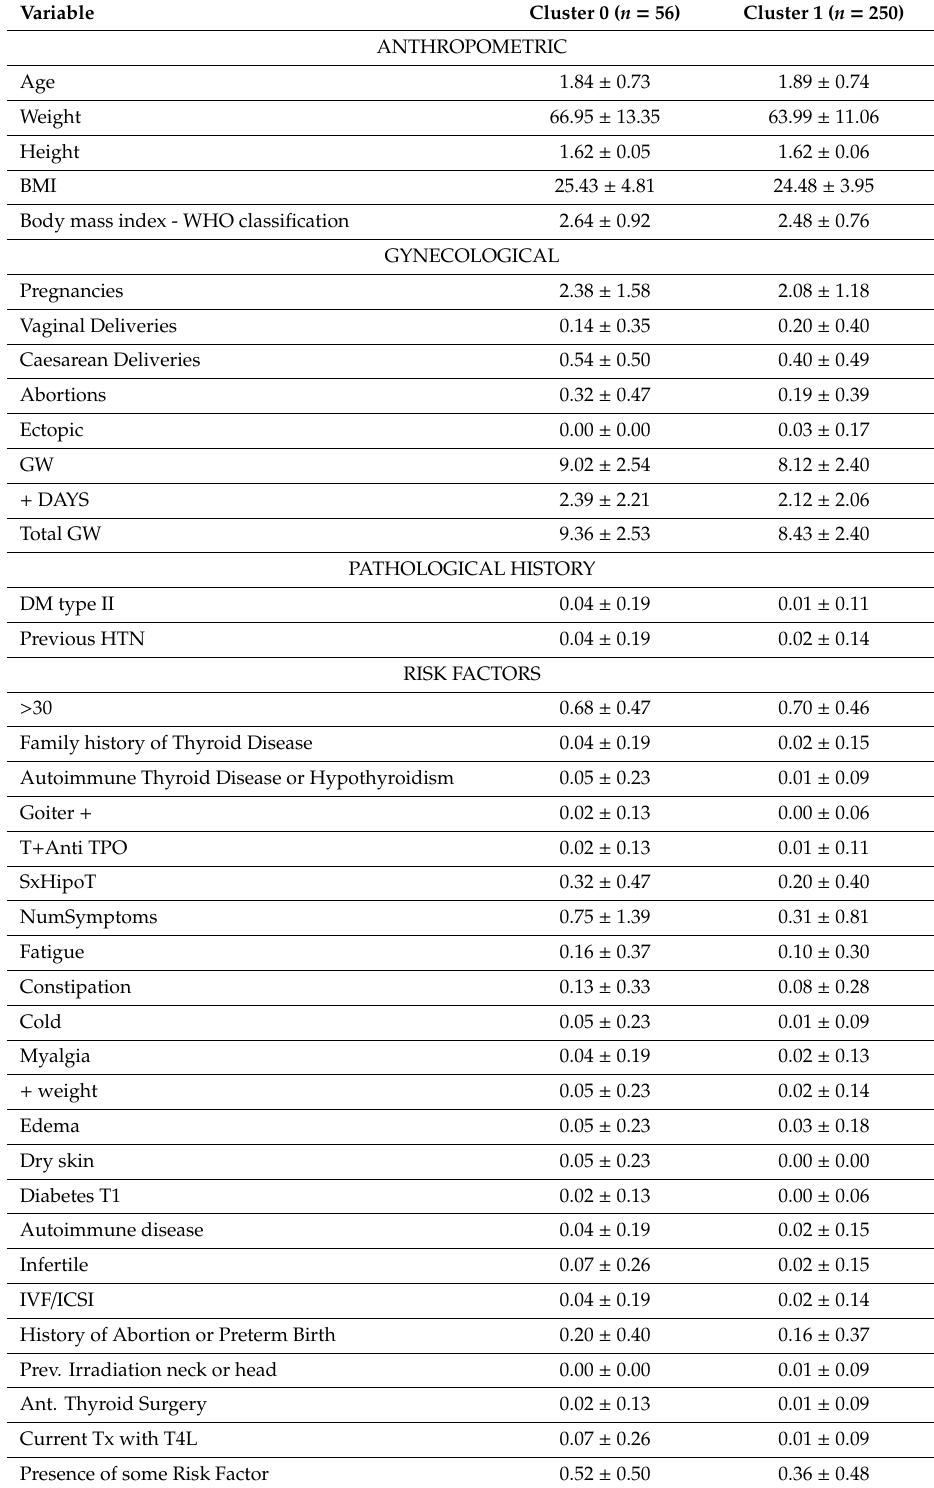
Table 6. Characteristics stratified by thyroid pathology. Features are presented as mean ±